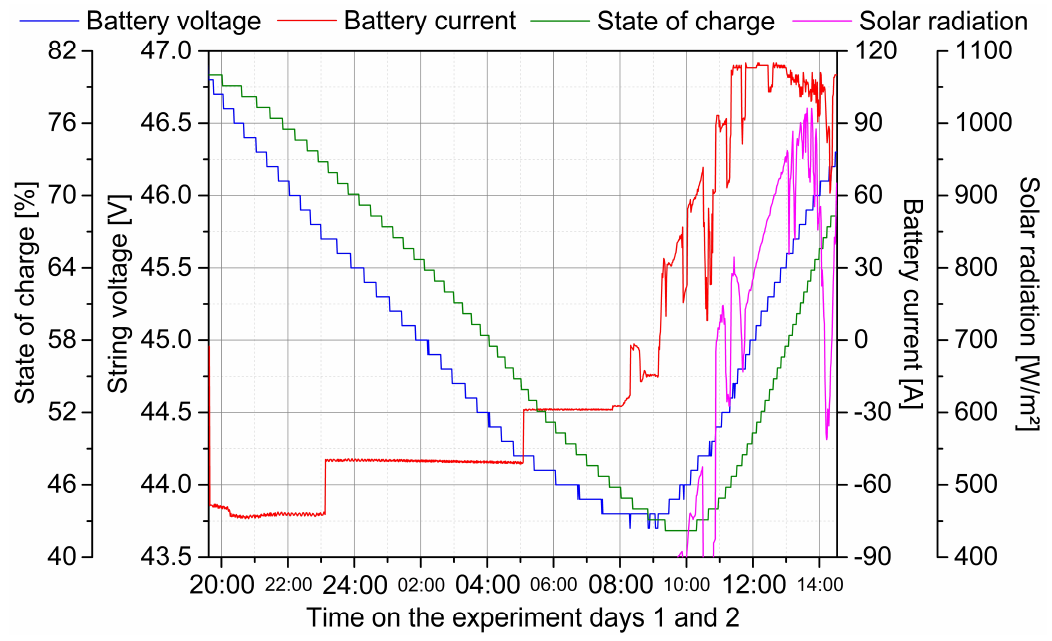
Figure 3. Charge and discharge experiment for the validation of the system performance and parameters. Plotted are the battery values voltage, current and state of charge as well as the solar radiation. At sunset on the first day of the experiment at 19:30, a defined load is connected to the system until the following day at 08:30, reducing the state of charge from 80% to 42% and the voltage from 46.6 V to 43.8 V. At 09:15 the DC / AC inverters are switched on to determine a starting point for the power feed. In the considered period until 14:30, the state of charge rises again to 68% and the battery voltage to 46.3 V. First at 11:20, the maximum charging current is reached for the first time.